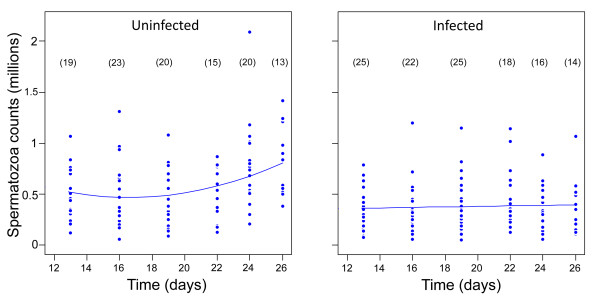
Spermatozoa counts in uninfected (left) and infected (right) male hosts. The counting was performed over the period where most of adult infected male Daphnia are expected to have spermatozoa and have survived infection (based on Figure 4). Infected males have fewer spermatozoa than uninfected males (linear regression controlling for variance due to the "Sampling day"; "Infection status", df = 1, F = 25.2, P < 0.001). While spermatozoa counts increased in uninfected males (linear regression with quadratic term, ("Age")^2, df = 1, F = 10.35, P = 0.001 and "Age" df = 1, F = 3.39, P = 0.07, left panel) it did not in infected males (linear regression, "Age", df = 1, F = 0.05, P = 0.82, right panel). Time is given as days after exposure to the parasite. Sample sizes are given in brackets.